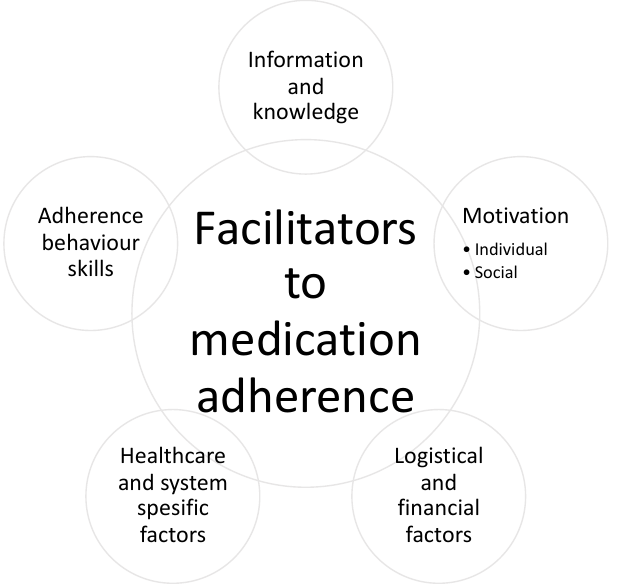
Figure 4. The identified key facilitators to medication adherence based on the included qualitative studies ( n = 89).